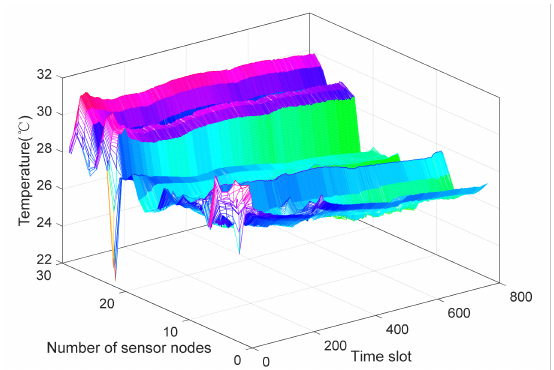
Figure 2. Spatial–temporal correlation features of DEI-Campaign